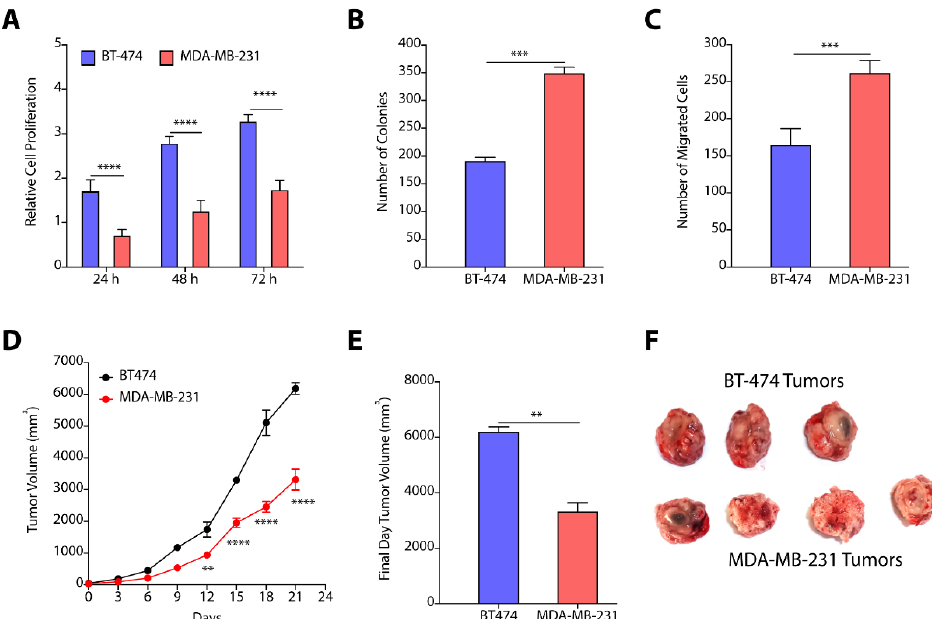
Figure 5. ( A ) Relative cell proliferation kinetics of BT-474 and MDA-MB-231 cells show enhanced proliferation of BT-474 cells as compared to MDA-MB-231 cells. ( B ) Number of colonies formed by BT-474 and MDA-MB-231 cells recorded higher number of colonies formed by MDA-MB-231 cells. ( C ) Quantification of number of migrated cells reveal higher number of MDA-MB-231 cells as compared to BT-474 cells. ( D – F ) Tumor growth kinetics ( D ), final day tumor volume ( E ), and pictures of excised tumors ( F ) witness enhanced proliferation of BT-474 tumors. Data in ( A – C ) are presented as mean ± SEM of at least three independent replicates, and were analyzed by unpaired student’s t -test for. Data in ( D , E ) are presented as mean ± SEM ( n = 3/4), and were analyzed using two-way ANOVA for Figure 5( D ), and using unpaired student’s t -test for ( E ). p -value: ** p < 0.01, *** p < 0.001, **** p < 0.0001.